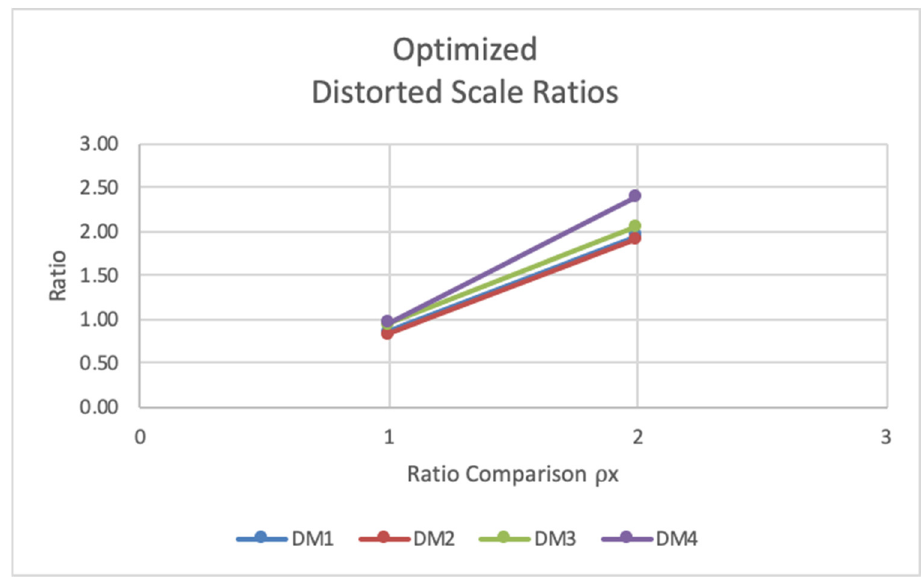
Figure 10. Case #11 adjusted distorted scale ratios.